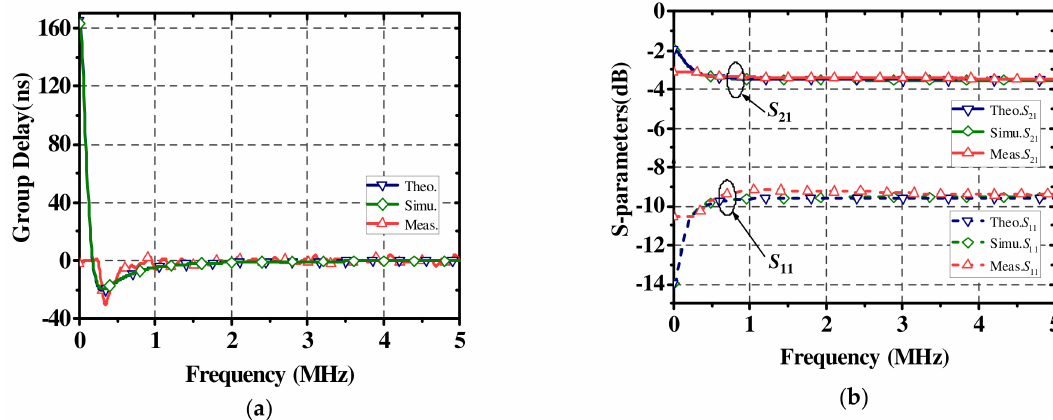
Figure 9. High-pass NGD circuit ( a ) group delay of high-pass NGD circuit. ( b ) S 21 and S 11 of high-pass NGD circuit.